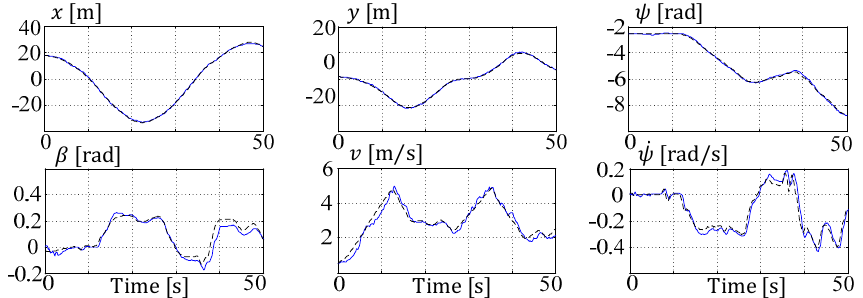
Figure 18. ESTM moving horizon estimation / estimator multiple shooting (MHE MS) up V1 ( n d = 2) state estimations (blue) vs. reference (black).